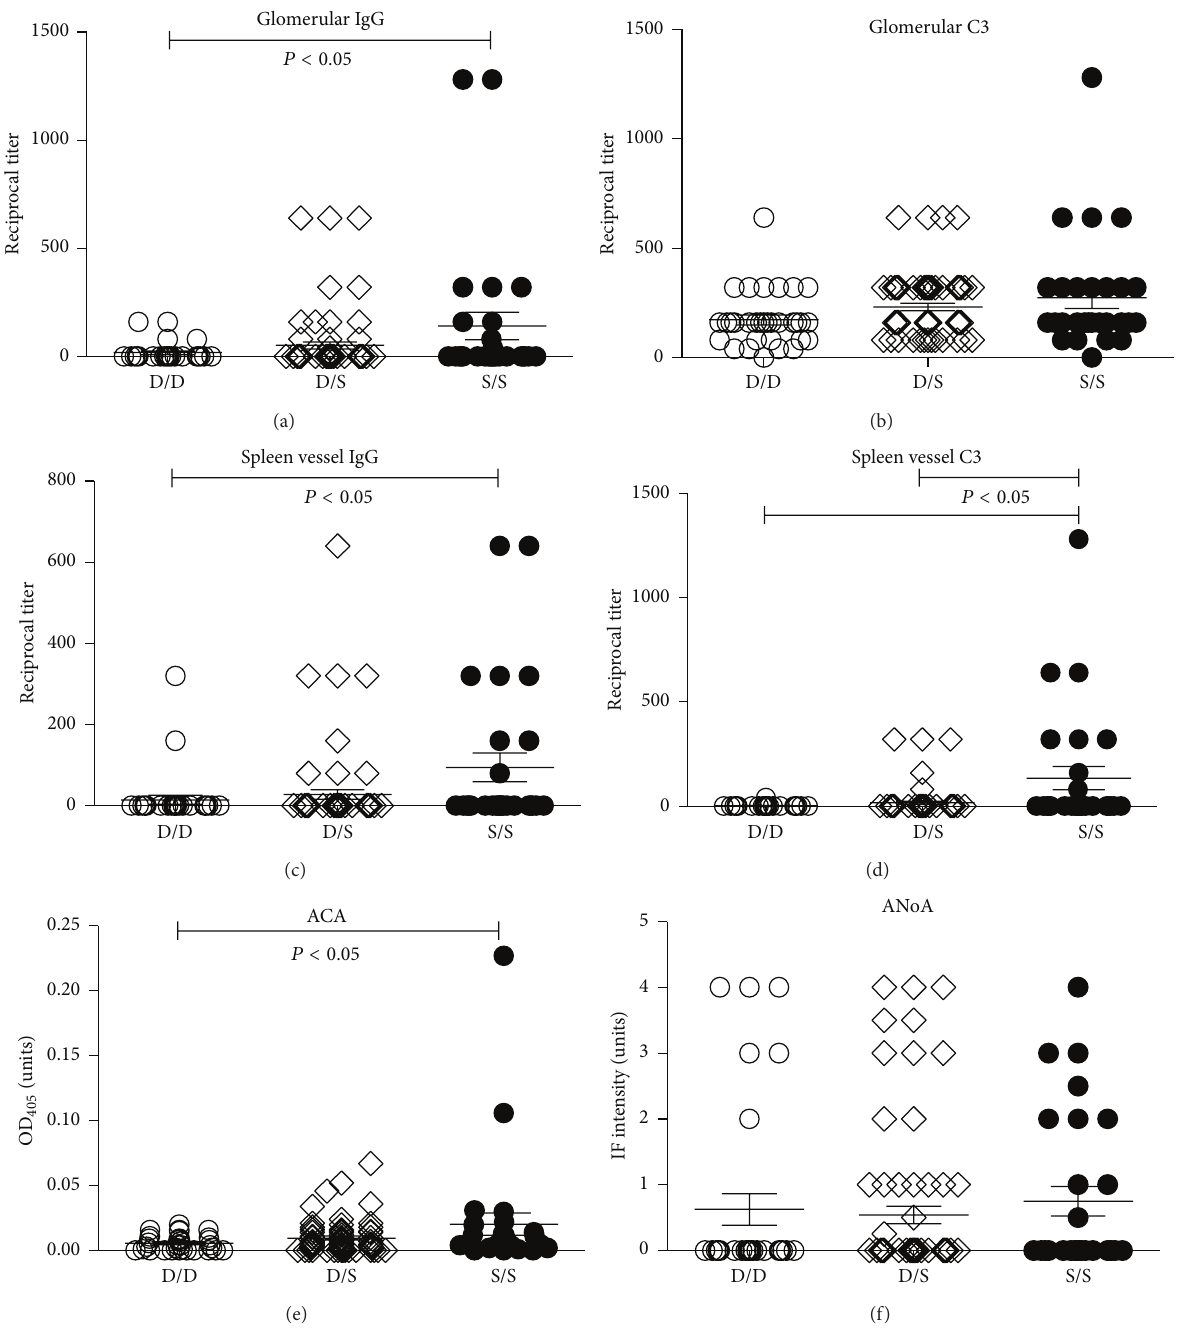
Figure 4: Presence of the DBA/2 tandem repeat is associated with reduced immune deposits. Tandem repeat genotypes (D/D, S/S D/S) were compared with features of mHgIA including glomerular deposits of IgG and C3, splenic vessel deposits of IgG and C3, antichromatin autoantibodies (ACA), and antinucleolar autoantibodies (ANoA) in 133 (SJL/JxDBA/2)F2 intercross